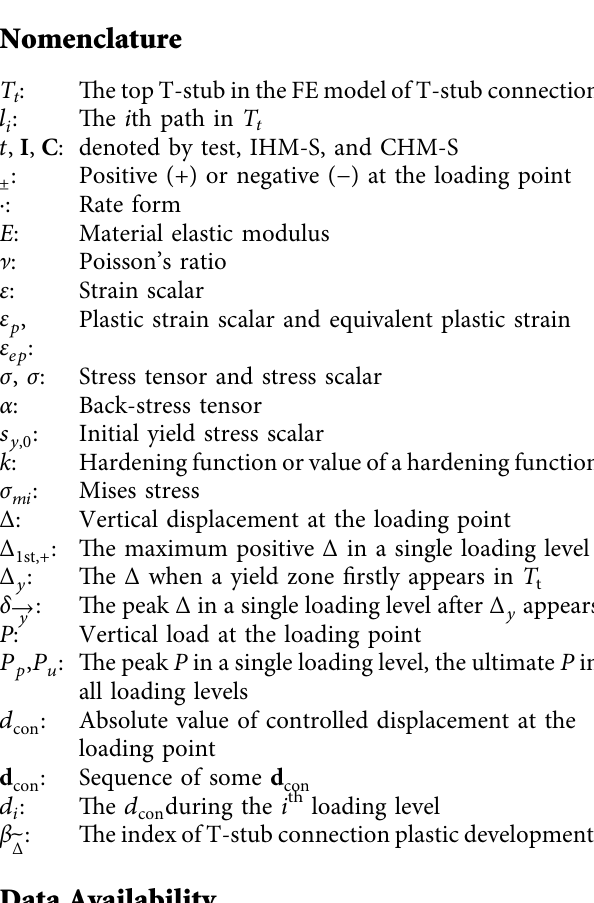
Table 4: Comparison between some positive peak loading forces P